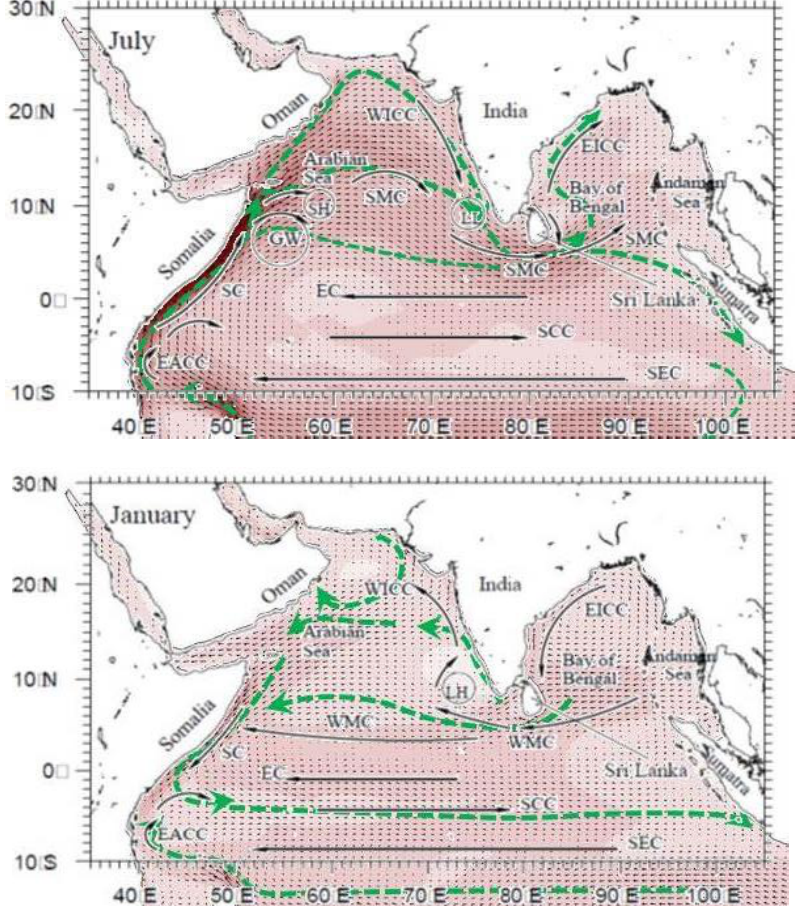
Figure 18. North Indian Ocean summer (top panel) and winter (bottom panel) monsoon